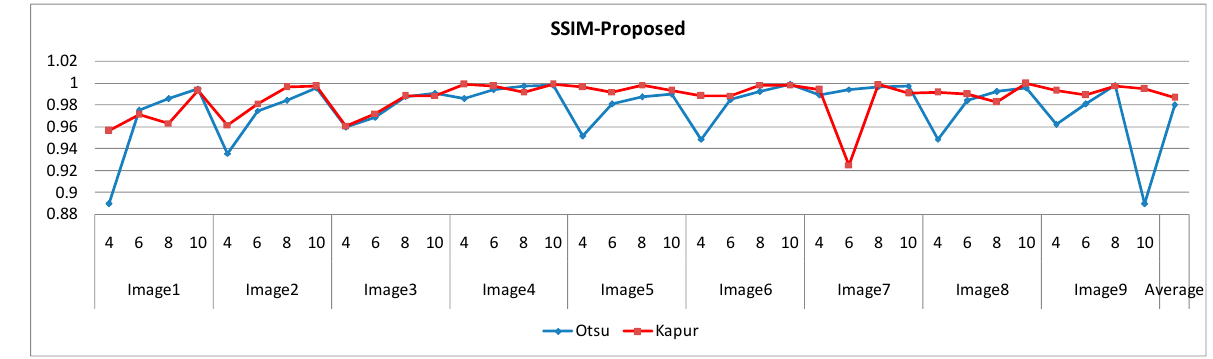
Figure 10. Comparison of PSNR based on Kapur’s method.